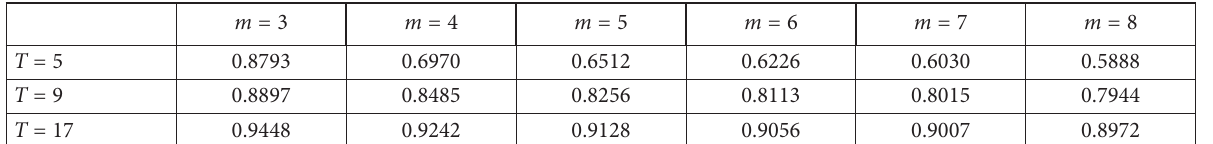
( ) CI H  for different values of m and O S